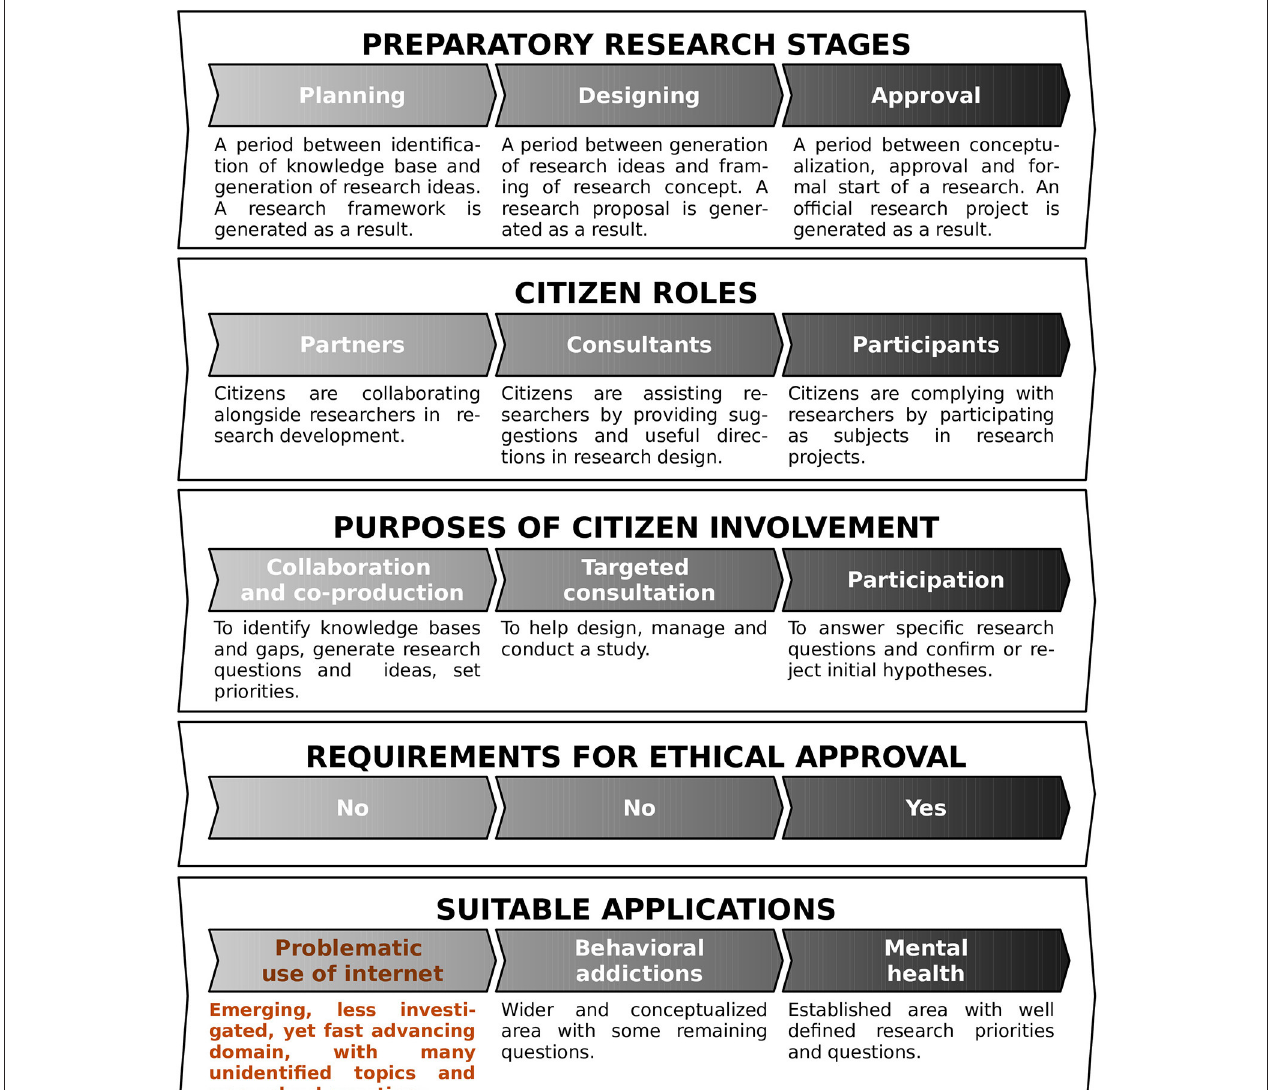
FIGURE 3 | The illustration outlines the main aspects of citizen involvement at the earliest stages of a research project, with special emphasis on their involvement in emerging areas of science. It highlights the roles played (as research partners, assistants, or participants), the nature of the commitment (based on co-creation, consultation, or participation), and the ethical requirements involved (where, depending on the stage of research, citizens may be consulted, or they may constitute the object of the